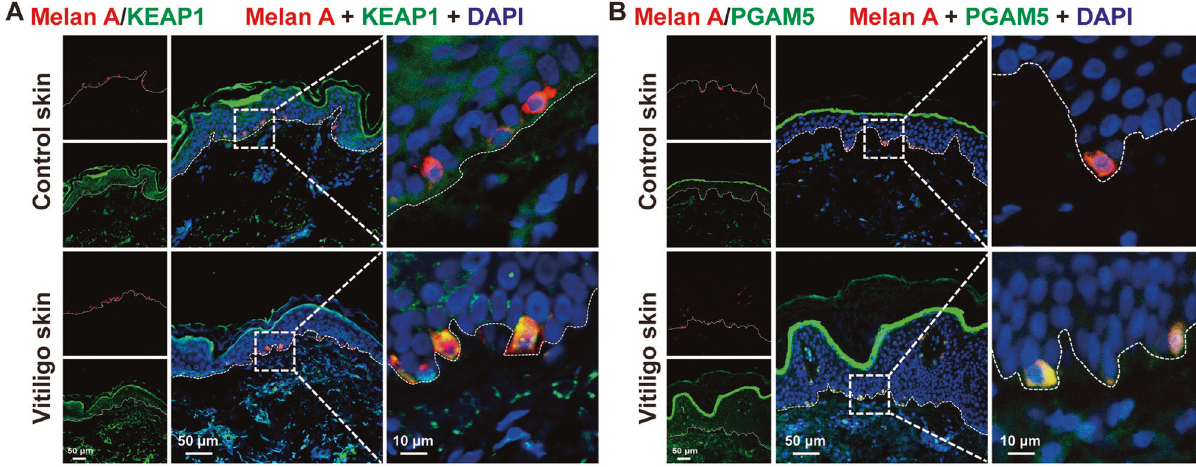
Fig. 4 The expression of KEAP1 and PGAM5 were upregulated in melanocytes of vitiligo patients. The expression of KEAP1 ( A ) and PGAM5 ( B ) in vitiligo lesions and healthy control epidermis by immuno fl uorescence